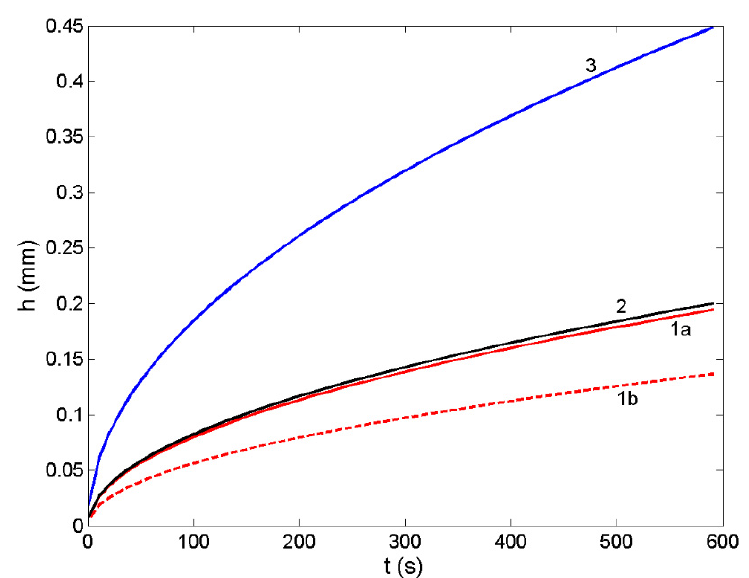
Figure 8. Infiltration depth of liquid Ir-80.5Si (at %) eutectic alloy into a porous SiC-substrate with a pore size of r = 65 µ m, calculated for T = 1873 K using different viscosity models: The Moelwyn- Hughes (curve 1a) and Terzieff’s model (curve 1b). For comparison, non-reactive infiltration of liquid Co-77.9Si (at %) eutectic alloy (curve 2) and pure Si (curve 3) on SiC are also shown.